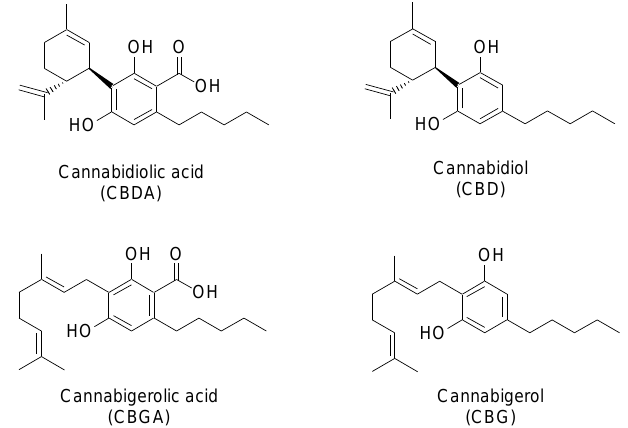
Figure 1. Chemical structures of main non-psychoactive cannabinoids in hemp inflorescences.